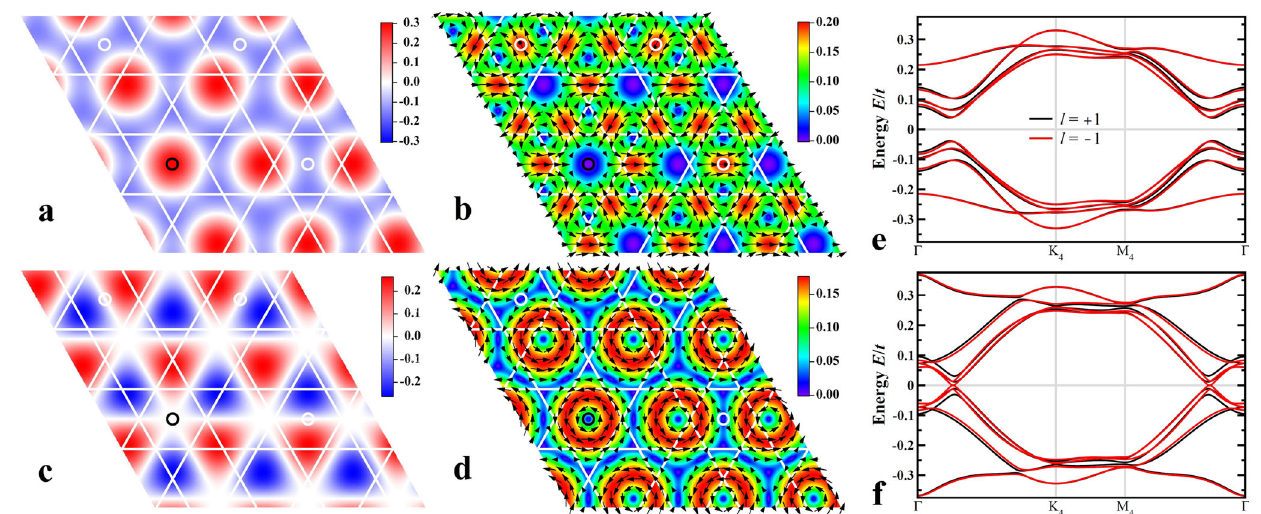
a a 4 Fig. 7 | Commensurate 4 0 × 0 PDWs. Spatial distribution of ( a ) PDW 0 , ( b ) 3 3 PDW 1 , ( c ) PDW 0 0 , and ( d ) PDW 0 1 , evaluated with Δ p =0.1 t . Small black and white circles mark the C 6 rotation and inversion centers of the loop-current CDW in Fig. 2a. e Low-energy BdG quasiparticle bands for PDW ±1 . f Low-energy BdG